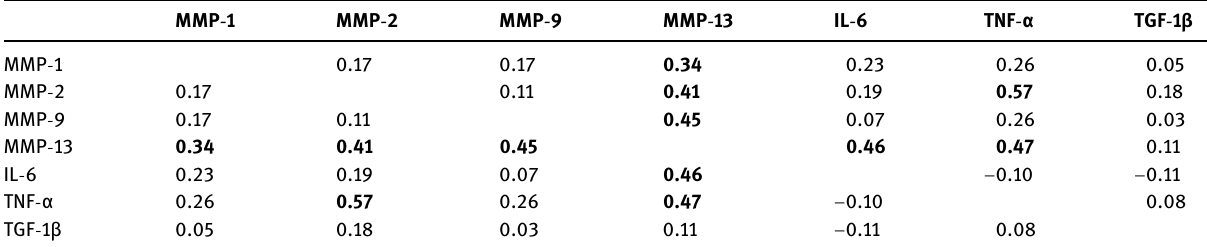
Table 1: Pearson ’ s correlation between the investigated